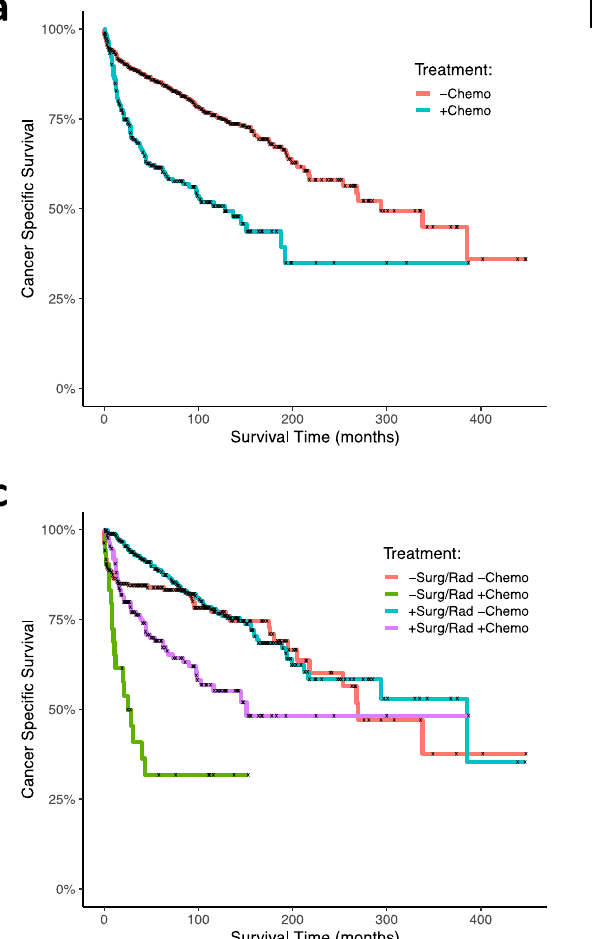
Figure 3. Kaplan–Meier curves of ONB patient cancer-specific survival associated ( a ) with and without chemotherapy treatment, ( b ) with and without radiation therapy plus and surgery, and ( c ) combinations of chemotherapy, radiation, and surgery. Abbreviations: chemo, chemotherapy; surg, surgery; rad, radiation.